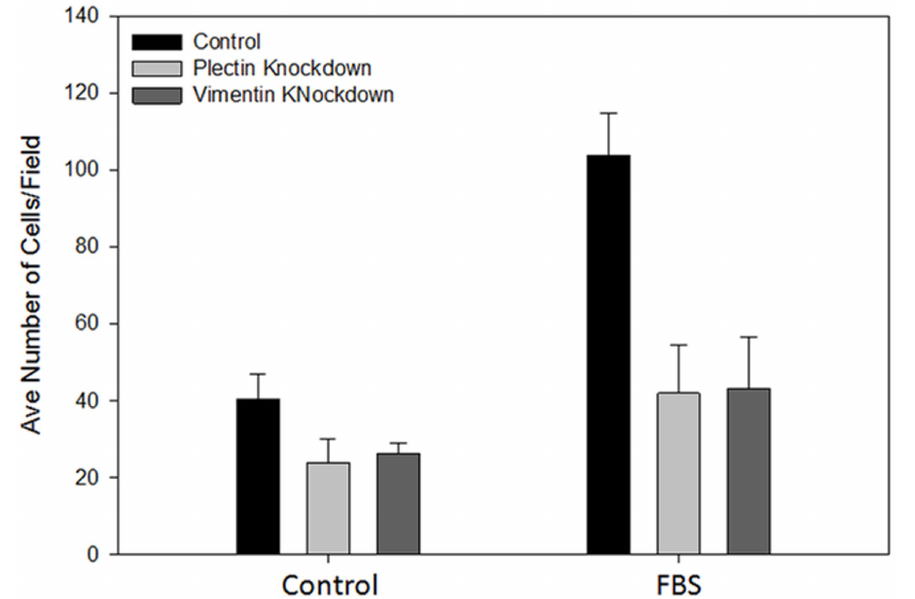
Figure 7. Suppression of plectin and vimentin significantly reduces the invasion ability of PC3-ML2 cells. Cells were transfected with control, plectin and vimentin siRNA and allowed to invade using a transwell migration assay. The invading cells were stained and three randomly selected fields were counted. The number of invading cells was significantly lower in the plectin and vimentin siRNA compared to the control siRNA transfected cells, P ,